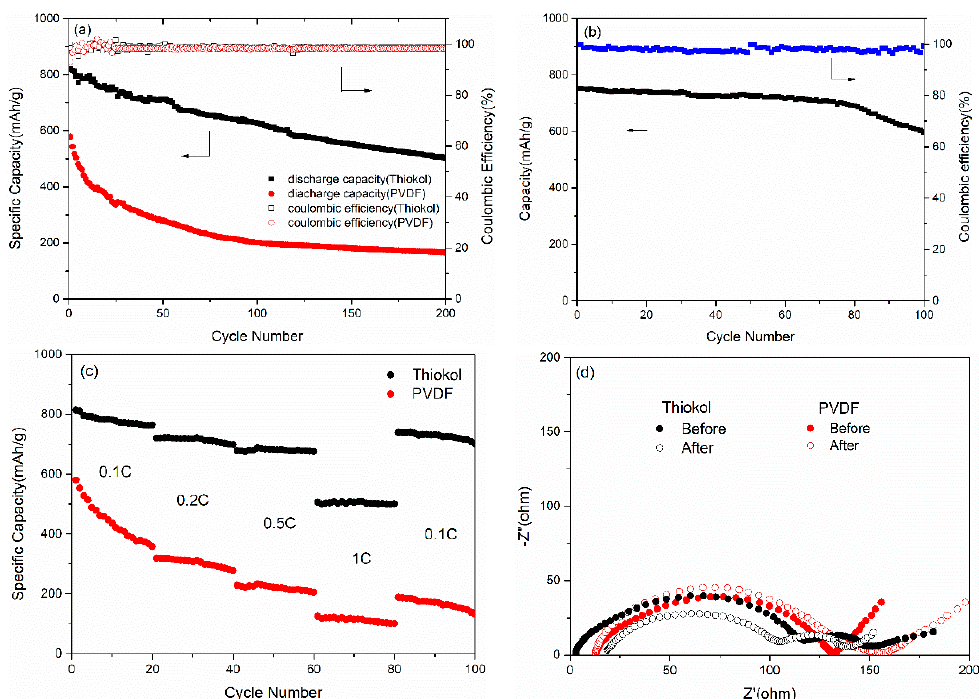
Figure 2. ( a ) Cycling performance of the battery at 0.1 C with the binder of Thiokol and PVDF, respectively; ( b ) Cycling performance of the battery with the Thiokol binder at 0.5 C; ( c ) Cycling performance of the battery with the Thiokol and PVDF binder at different rate; ( d ) Electrochemical impedance spectra of the battery with the Thiokol and PVDF binder before and after